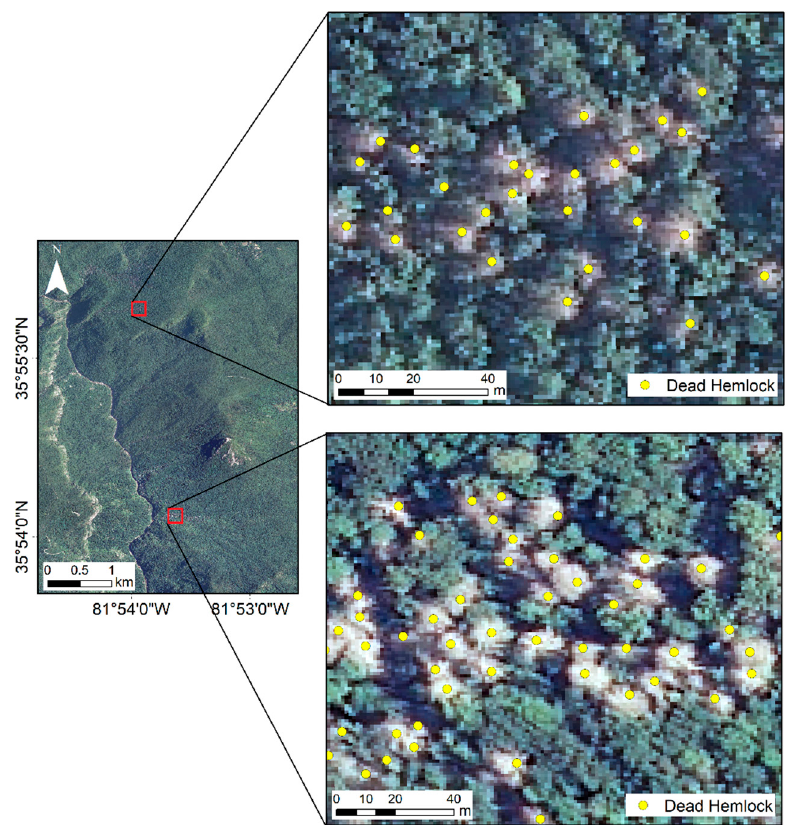
Figure 3. Examples of the digitized dead or dying hemlocks (yellow points) on the National Agriculture Imagery Program (NAIP) image (5 July 2010) at two sample sub-regions of the study site.